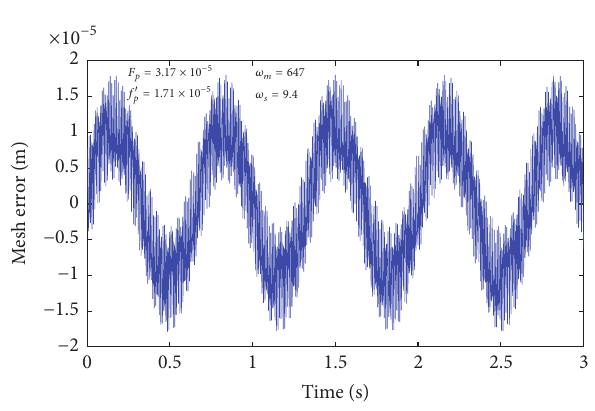
Figure 7: Transmission mesh